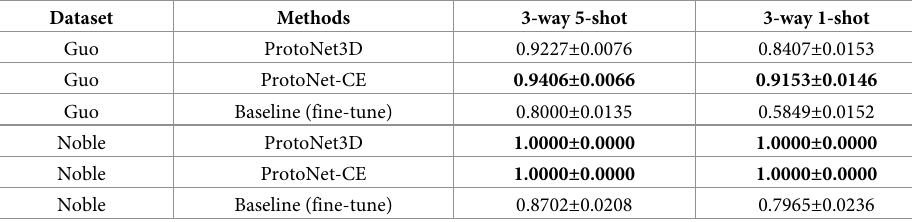
Table 4. The classification accuracy of the real datasets of